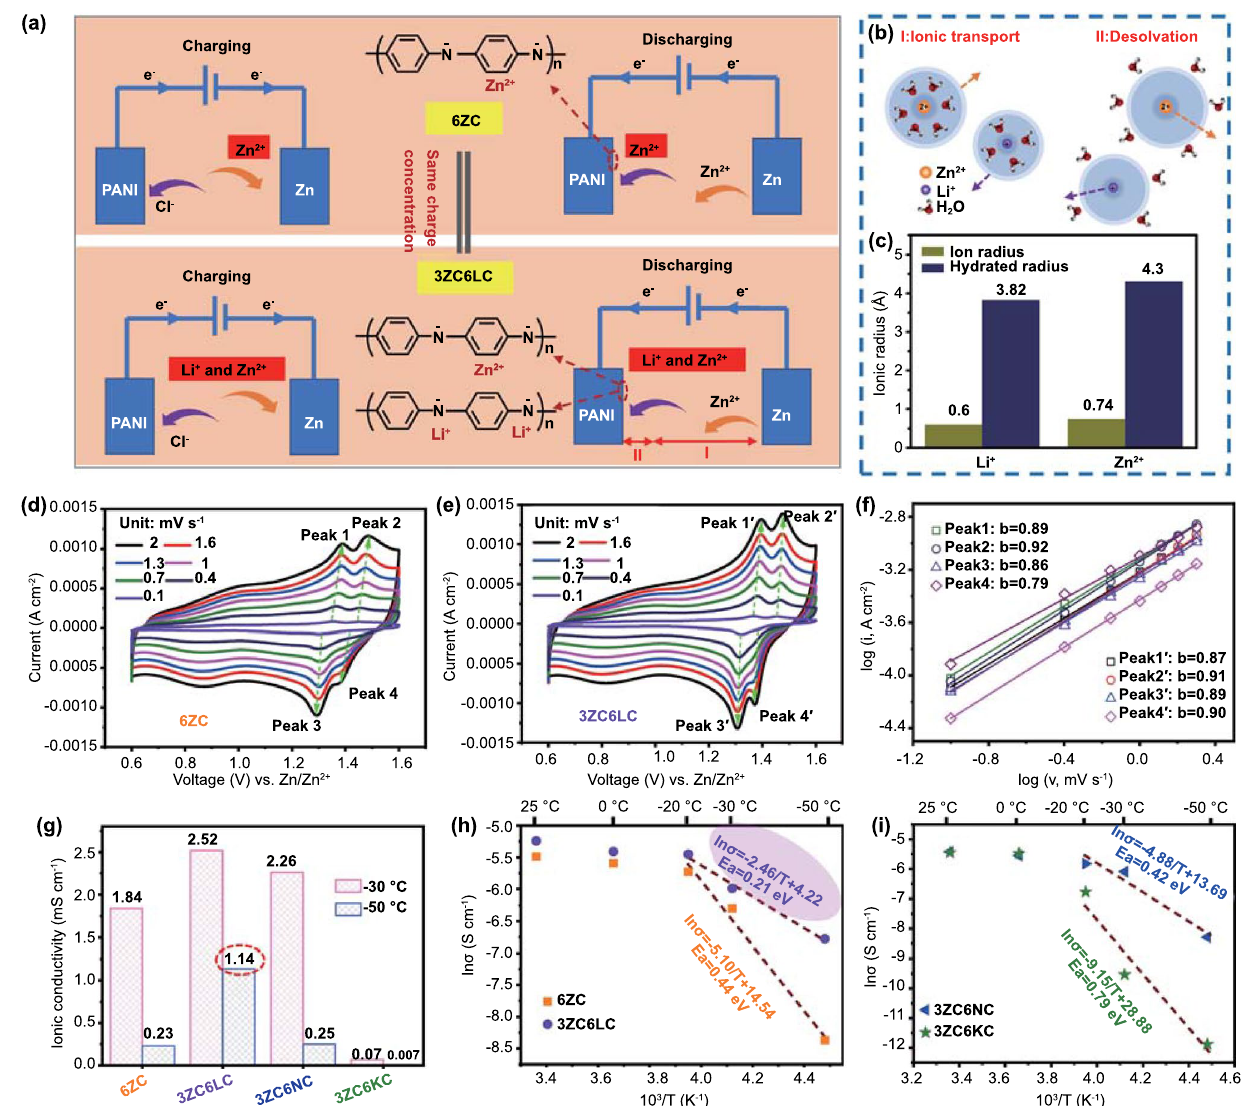
Fig. 5 a Redox mechanism of PANI/Zn batteries with 6ZC and 3ZC6LC, respectively. b Schematic diagram of the transport and desolvation of hydrated zinc ion and lithium ion. c The ionic radius and hydrate ion radius of zinc ion and lithium ion. CV curves of full PANI/Zn batteries using d 6ZC and e 3ZC6LC at various scan rates from 0.1 to 2.0 mV s −1 (−30 °C). f Corresponding determination of the b values. g The σ of hydrogels electrolytes. h Arrhenius plots of 6ZCand 3ZC6LC, respectively. i Arrhenius plots of 3ZC6NC and